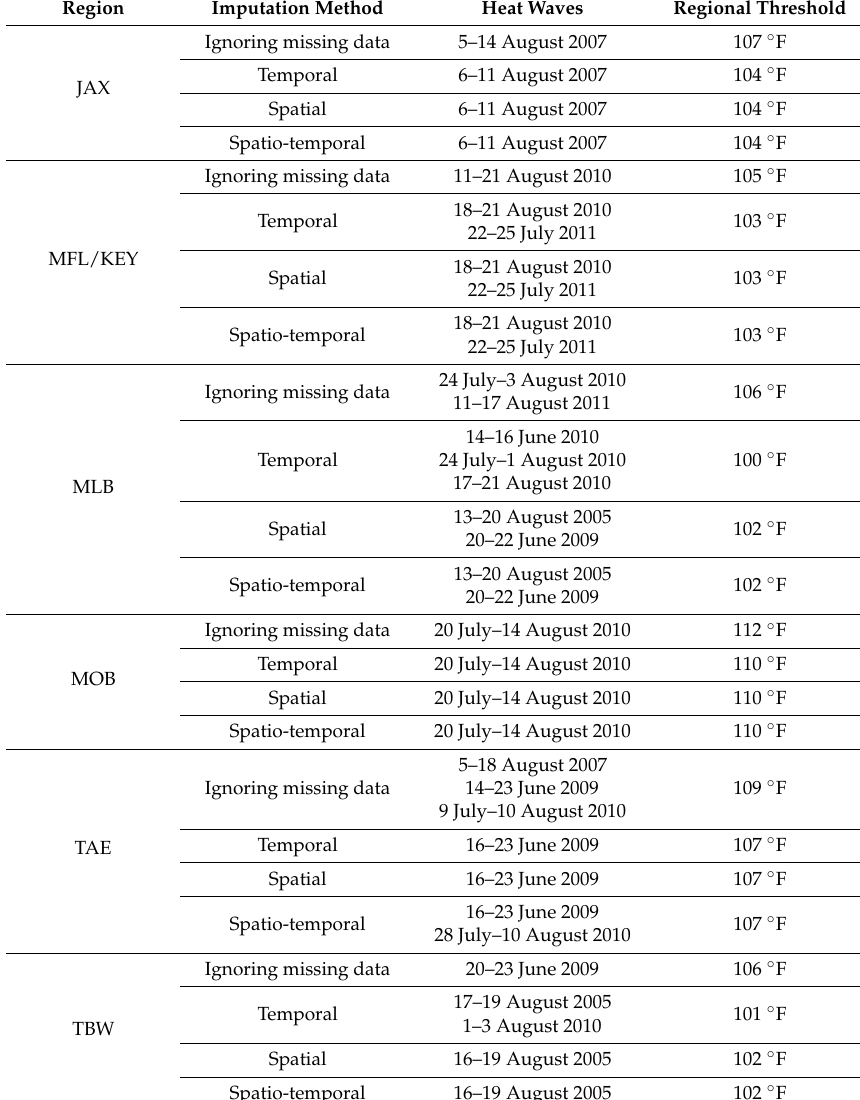
Table abbreviations: Jacksonville region (JAX), Miami/Keys region (MFL/KEY), Melbourne region (MLB), Mobile region (MOB), Tallahassee region (TAE), Tampa Bay region